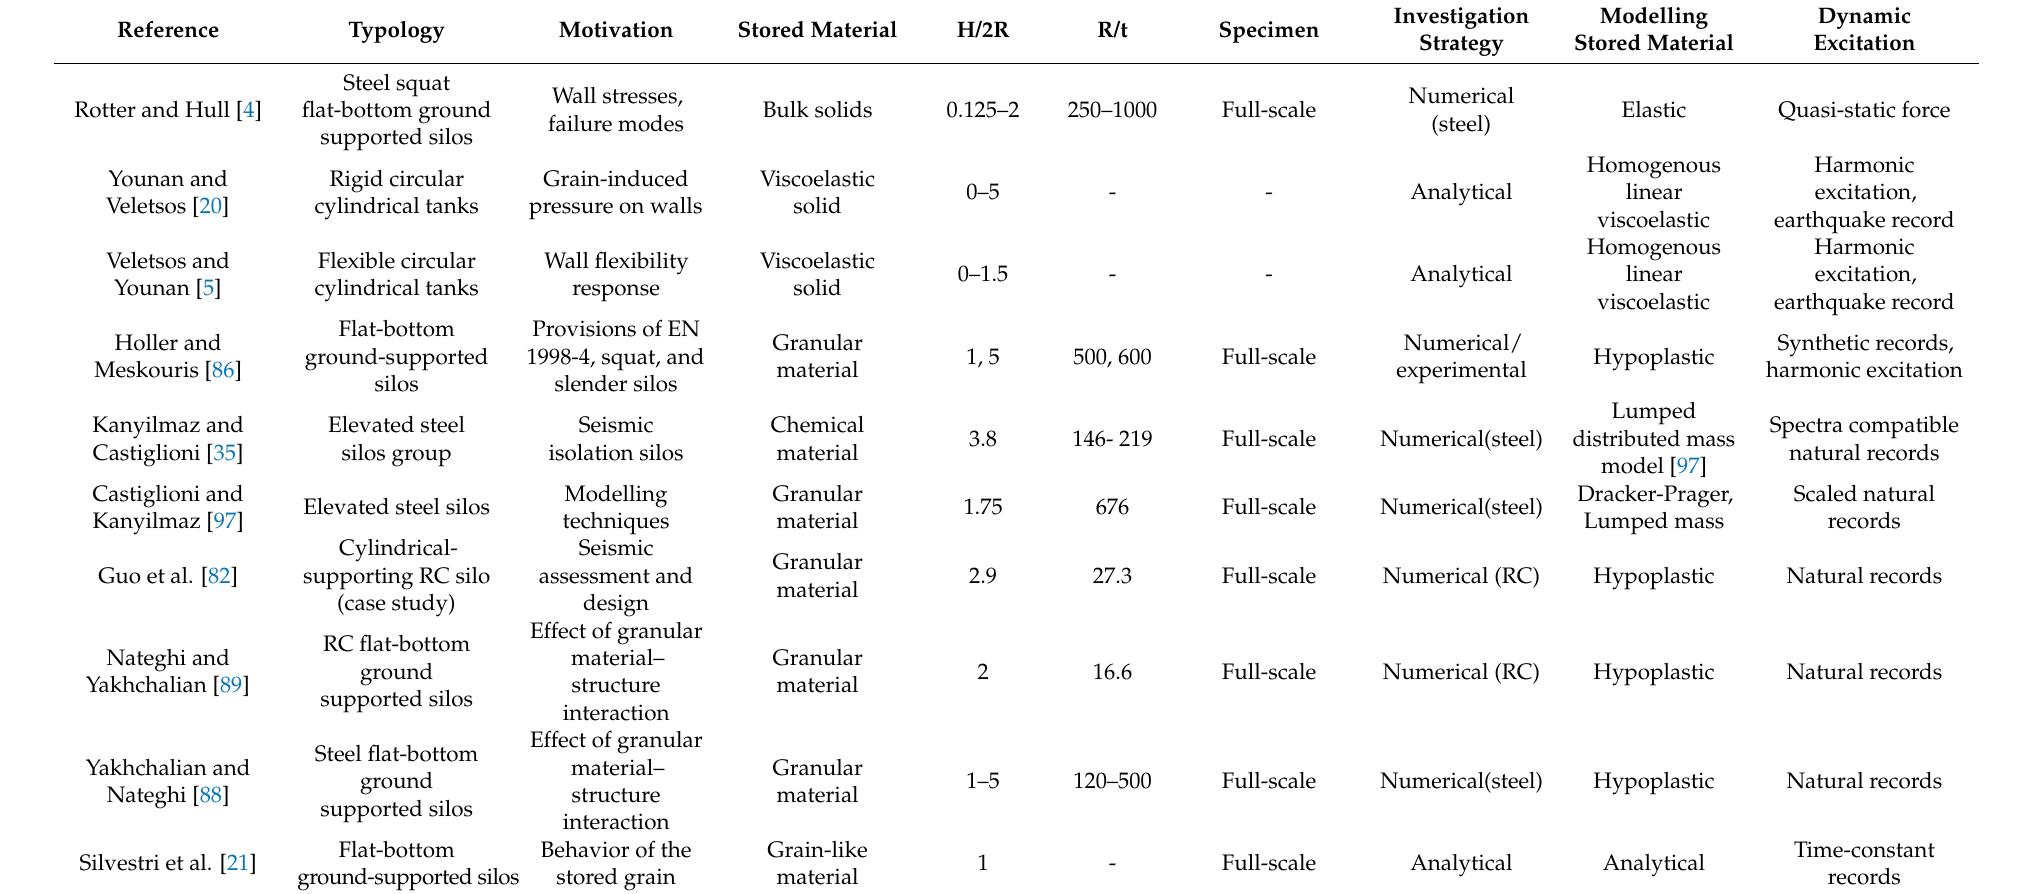
Table 2. Earthquake loading and seismic response of silos. H, R, and t indicates the height, the radius, and the thickness of the